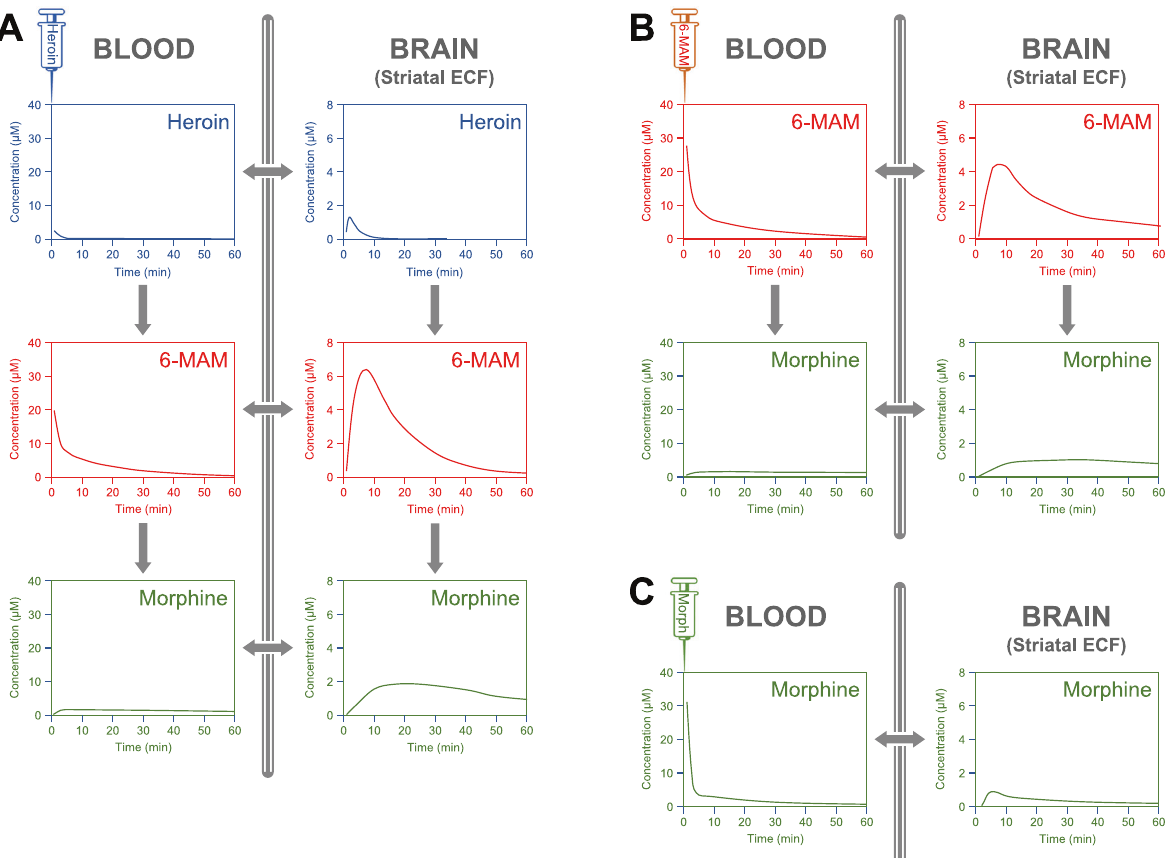
Fig. 4 Concentration-time pro fi les of heroin and its metabolites in the rat blood and brain. Concentrations of heroin (blue), 6-MAM (red), and morphine (green) in the blood and in the striatal extracellular fl uid of rats, after an i.v. injection of 1.3 µmol ( ffi 4 mg/kg) of heroin ( A ), 6-MAM ( B ), or morphine ( C ). Based on data extrapolated from Gottås et al. 2014 [20] and supplementary data (same animals of Fig. 3). Notice that in this study M6G was not quanti fi ed, as in the rat, under normal conditions, the synthesis of this metabolite is